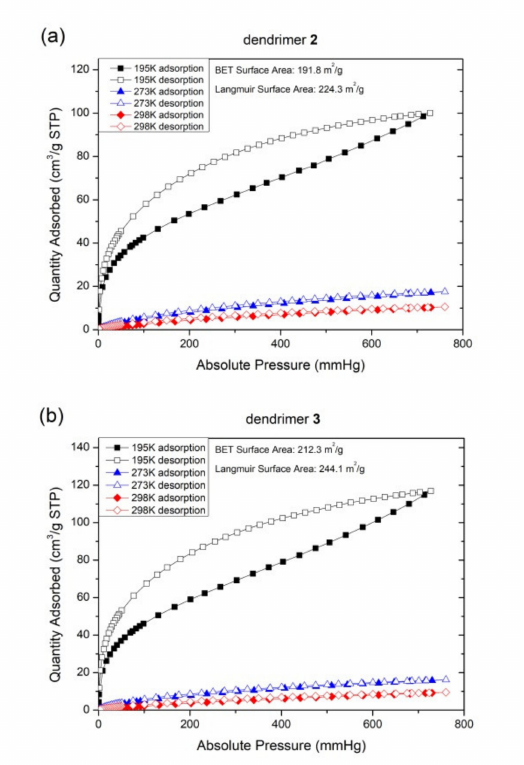
Figure 4. ( a ) The CO 2 sorption isotherms of dendrimer 2 at 195, 273, and 298 K. ( b ) The CO 2 sorption isotherms of dendrimer 3 at 195, 273, and 298